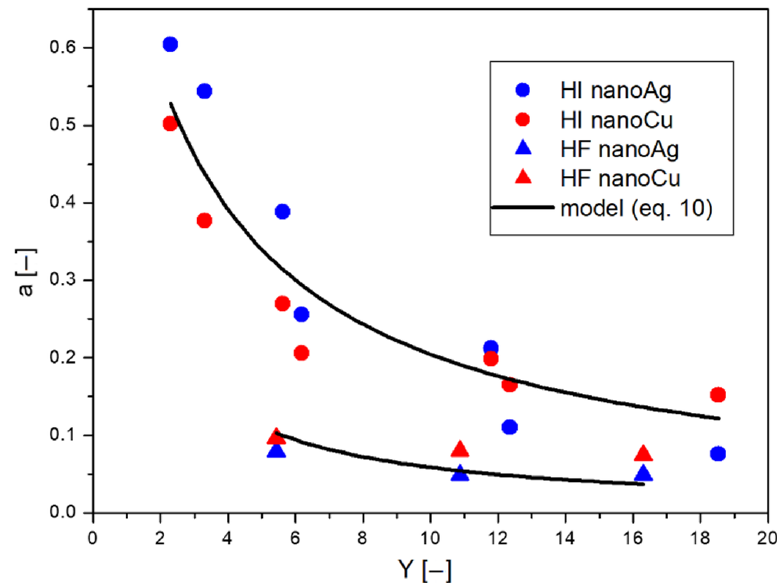
Figure 5. Dependence of coefficient a on surface parameter Y for passive diffusion process of silver and copper nanoparticles through filters with different wettability.